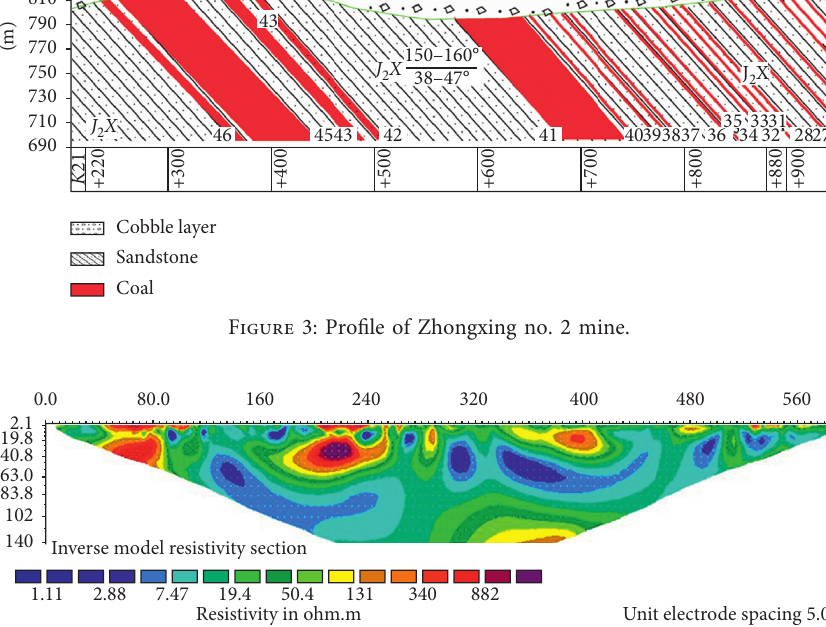
Figure 4: WA-4 resistivity inversion map.